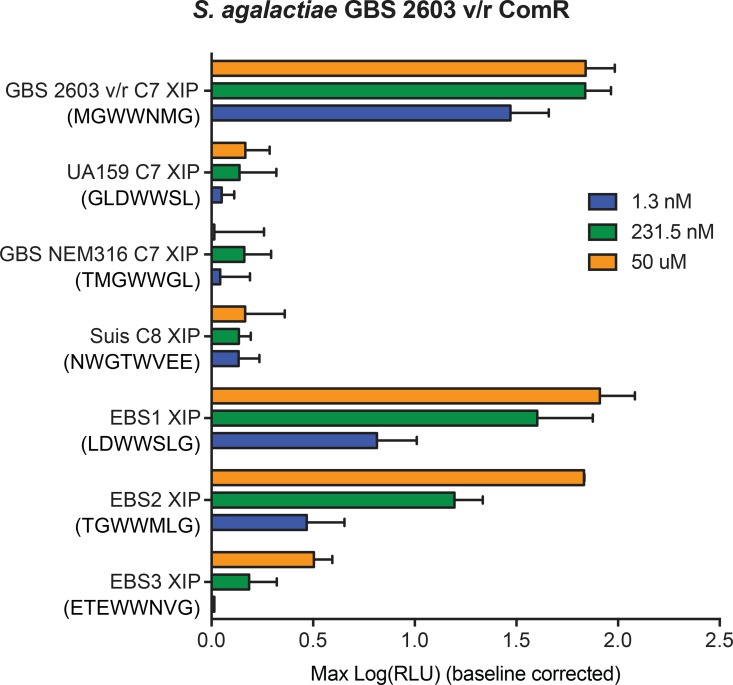
Designed XIP agonists of ComR S. agalactiae 2603.XIP peptides found to be ineffective signals for ComR S. agalactiae 2603 were redesigned to satisfy hypothetical ComR-activating criteria. Designed synthetic peptides were titrated to strain ES1 carrying ComR S. agalactie 2603 reporter and maximum relative luciferase activities were recorded.